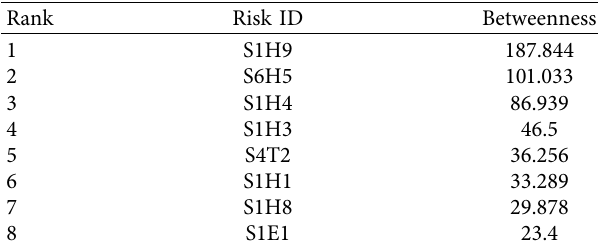
Table 9: Top 8 safety risk factors with high betweenness centrality.